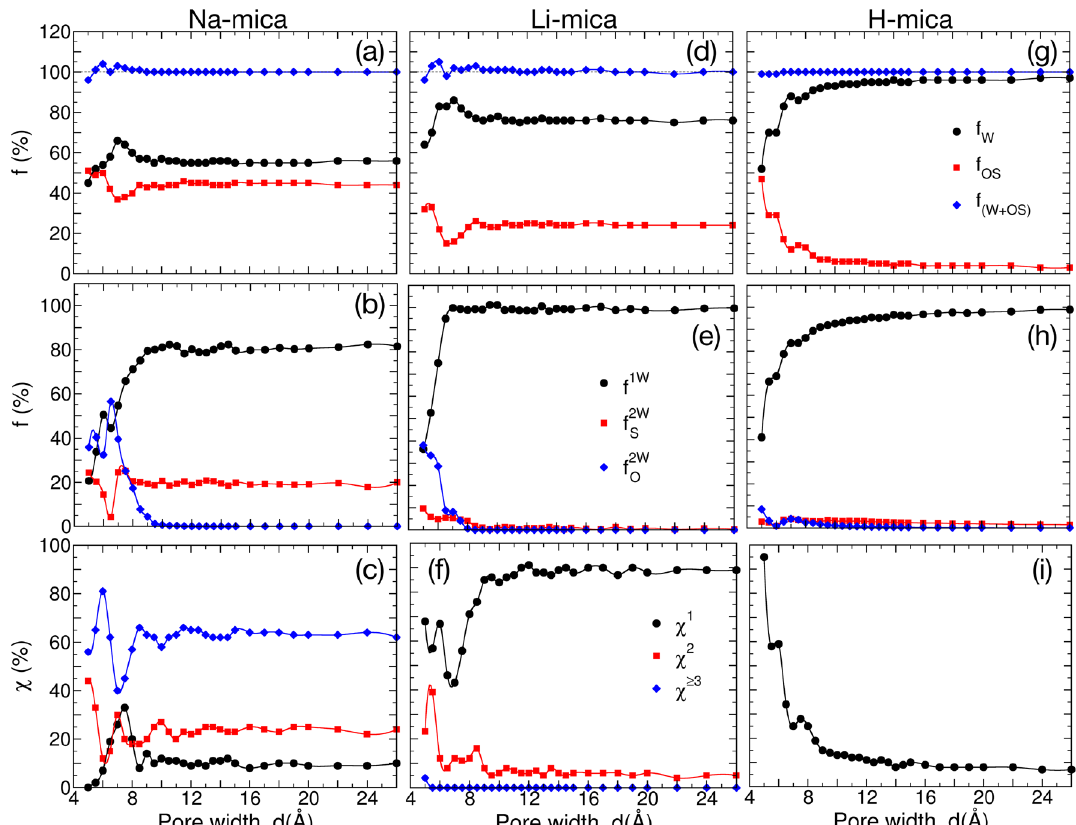
Figure 10. Detailed analysis of (top row) cation hydration shell, (middle row) water sharing in cation- hydration, and (bottom row) cation-hydration by surface atoms for ( a – c ) Na + , ( d – f ) Li + , and ( g – i ) H + ions in respective M-mica system. (Top row) Variation of normalized hydration number due to water ( fW —black circle), oxygen of surface ( fOS — red square), and total ( fW+OS — blue diamond) with respect to d . f1W (Middle row) Percentage of water molecules hydrating only one cation (i.e., no sharing, —black circle), f2W two cations of same side (i.e., lateral sharing, S —red square), and two cations of opposite side (bridge f2W formation, O — blue diamond). (Bottom row) Percentage of cations hydrating only one surface oxygen ( χ 1 — black circle), simultaneously two surface oxygens ( χ 2 — red square), and three (or more) surface oxygens ( χ ≥ 3 — blue diamond). Percentage of cations not hydrating surface oxygens and are forming OSCs or DCs is χ 0 = 100 − (cid:31) χ i i > 0